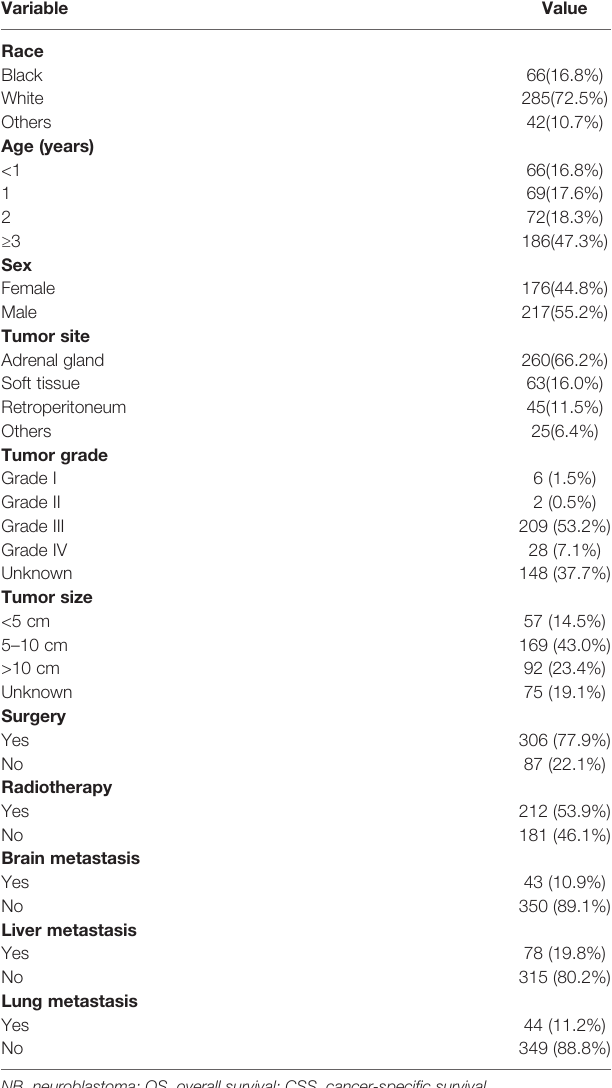
TABLE 1 | Baseline characteristics of 393 NB patients with bone metastasis at diagnosis.